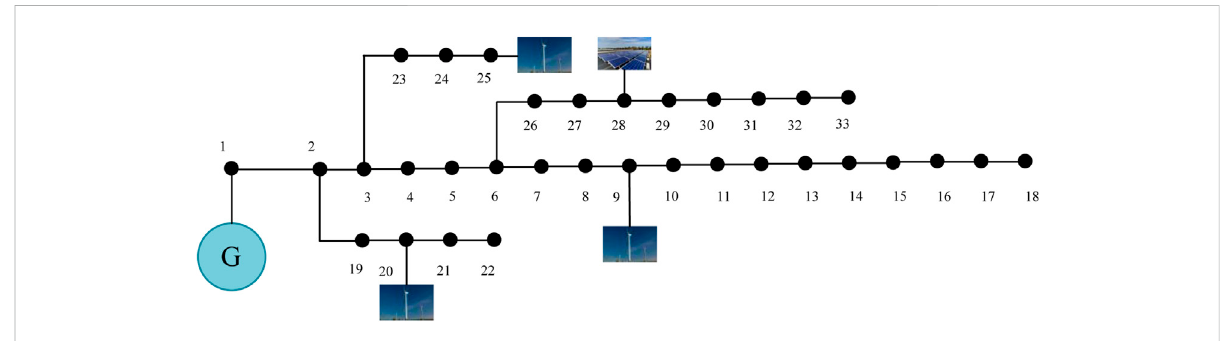
FIGURE 2 Topology of the extended IEEE-33 bus.